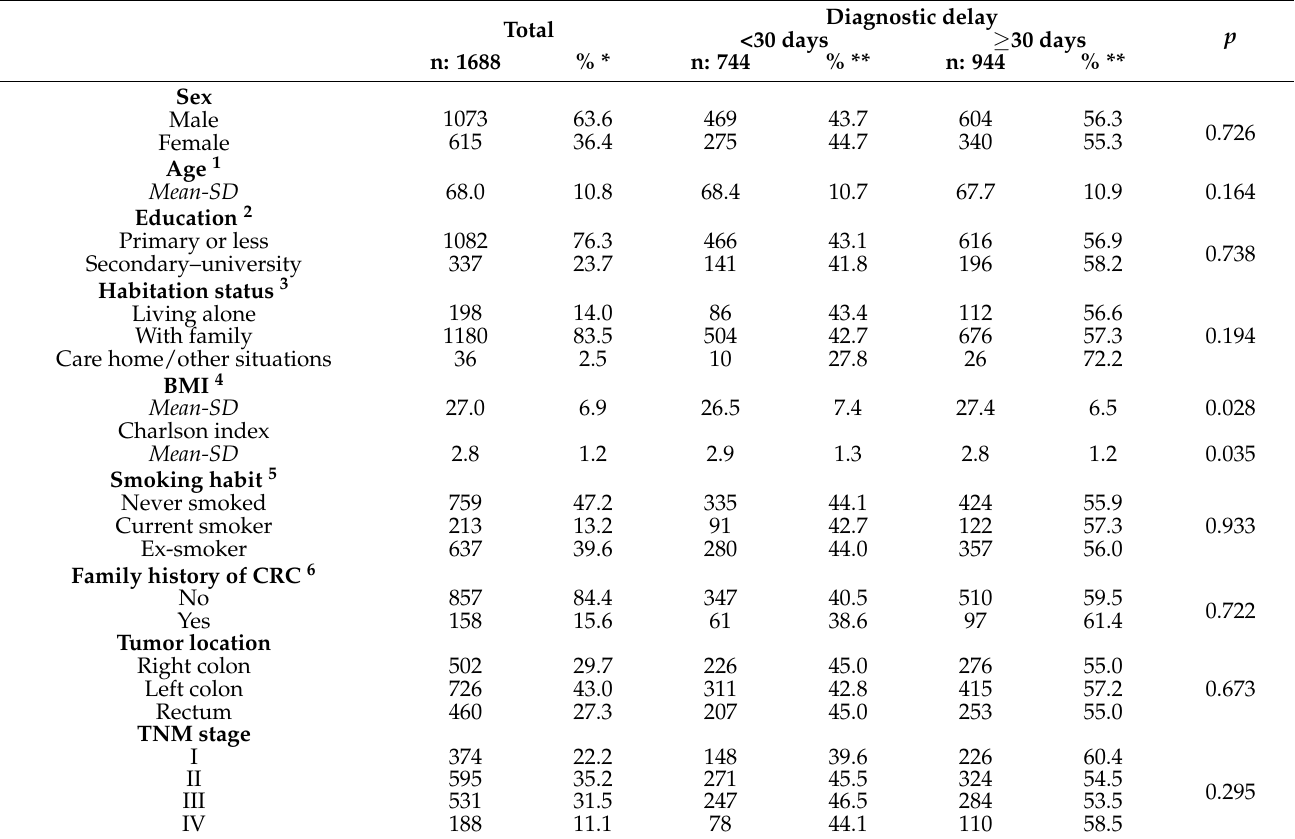
Table 1. Sociodemographic and clinical characteristics for the total sample and segmented by diagnostic